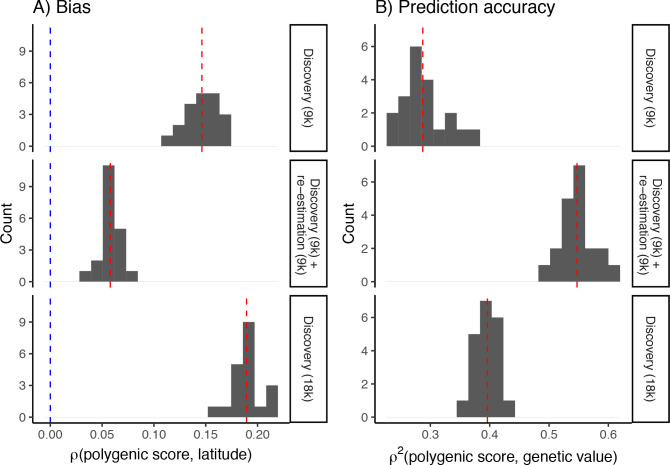
Bias (A) and prediction accuracy (B) of polygenic scores calculated using different variant ascertainment and effect size estimation schemes.The bias is smallest and prediction accuracy greatest when variants are ascertained in a standard genome-wide association study (GWAS) and their effects reestimated in an independent sample of unrelated individuals (middle row). This explains the bias and prediction accuracy seen when variants were ascertained in a standard GWAS and their effects reestimated in siblings Figure 6. Shown, for comparison, is the bias and prediction accuracy of polygenic scores calculated from effects discovered in a standard GWAS of 9K (top row) and 18K individuals (bottom row), respectively. Even though a larger GWAS improves prediction accuracy slightly, it also increases the bias. Blue dashed lines represent the expected bias and red dashed lines represent the observed mean of the distribution.